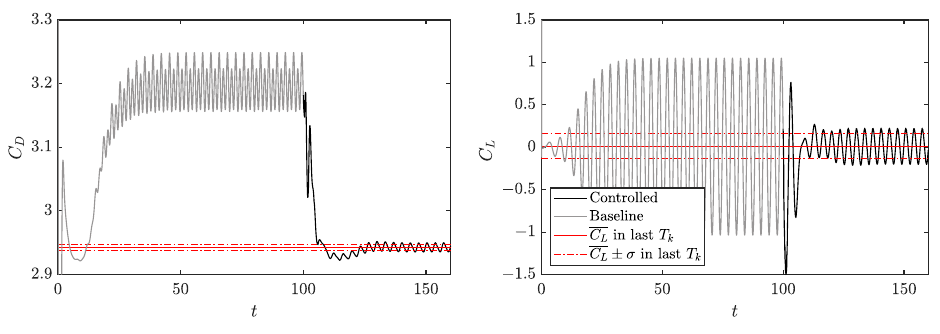
Figure 8. Temporal evolution of C D ( left ) and C L ( right ) obtained through the application of the DRL control (at t = 100), run in a deterministic mode, for Re = 100.